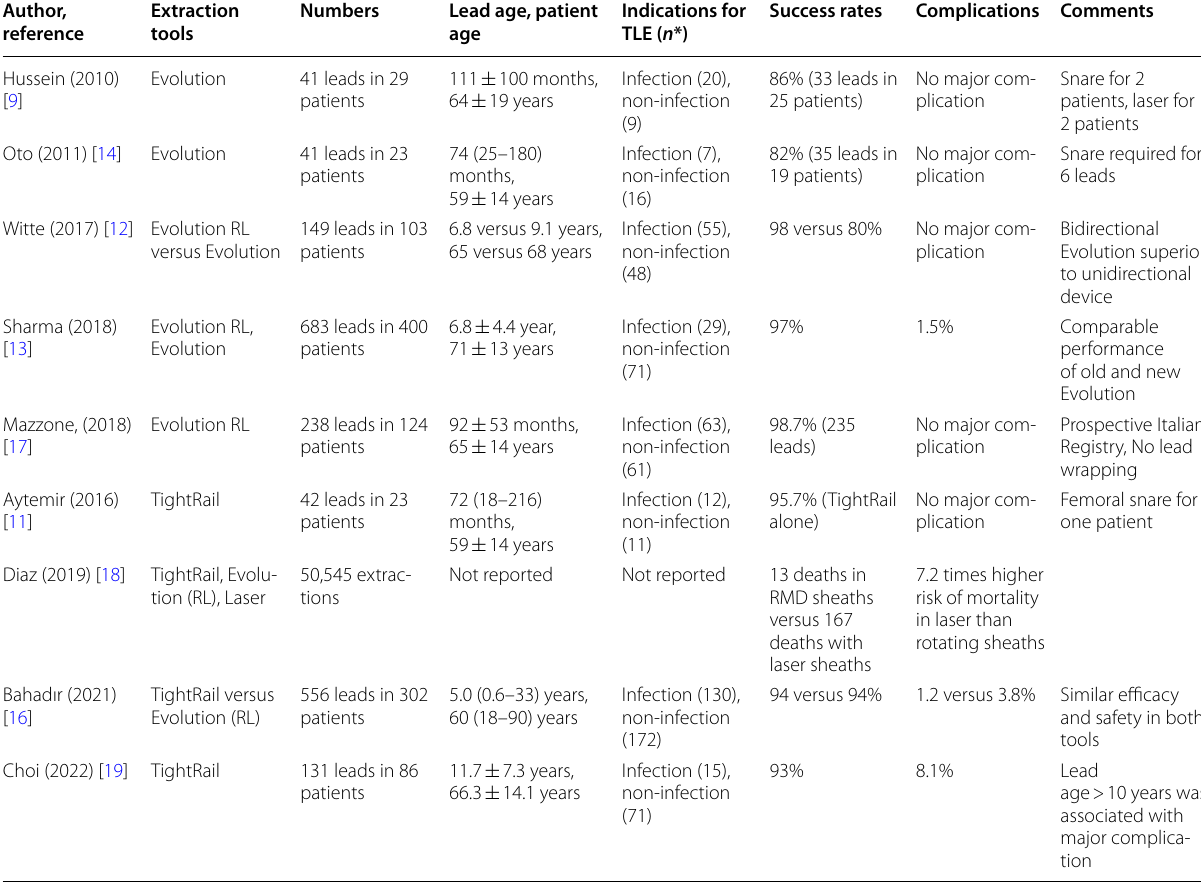
n *, number of patients